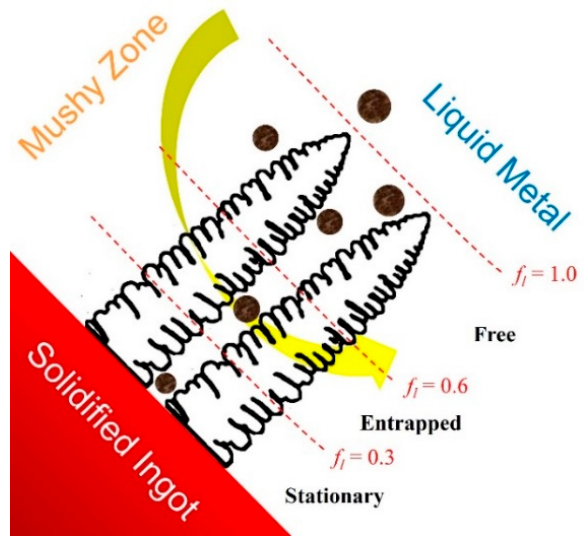
Figure 3. Schematic illustration of inclusion behavior during the solidification.